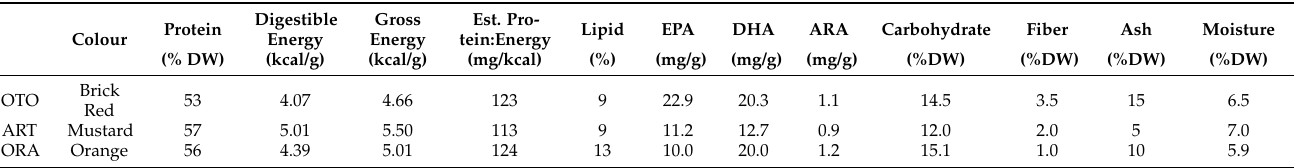
Table 2. Percent dry matter feed composition, energy content, and fatty acid profiles of the three larval diets tested in the present